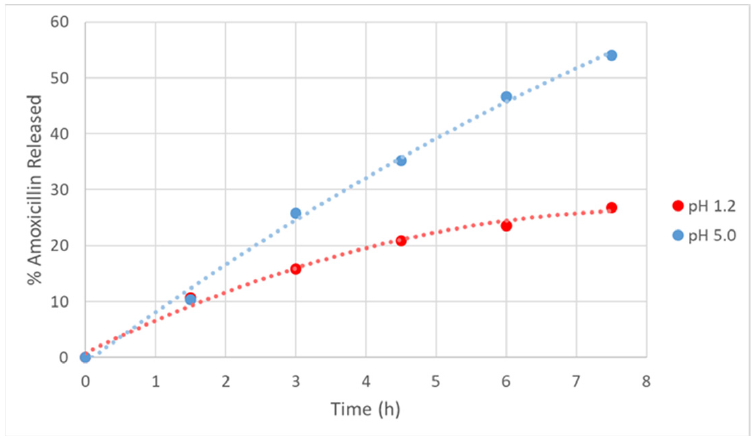
Figure 11. Cumulative drug release for GG-p(CAR 50 B 50 ), 10% of loaded amoxicillin, at two different pH levels.